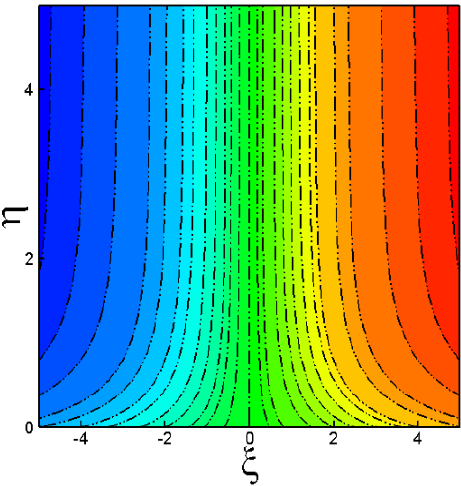
Figure 2. Streamlines pattern.